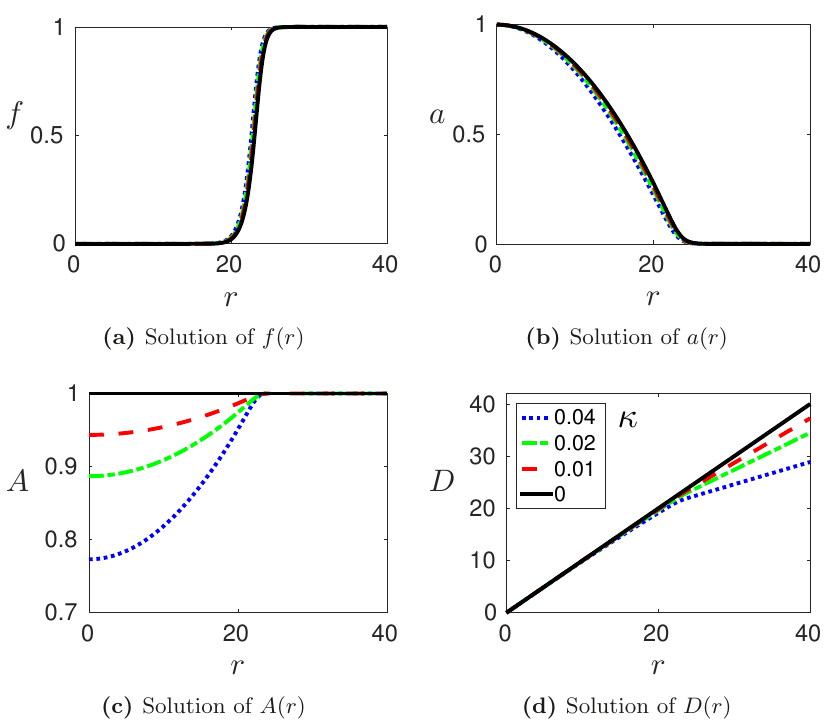
Figure 3. Thin-wall solutions of f ( r ), a ( r ), A ( r ), and D ( r ) respectively. n = 50, e/ √ 4 π = 1, ǫ = 0 . 005. The line patterns (solid line, dashed line, dash-dotted line, dotted line) correspond to κ = (0 . 00 , 0 . 01 , 0 . 02 , 0 . 04),